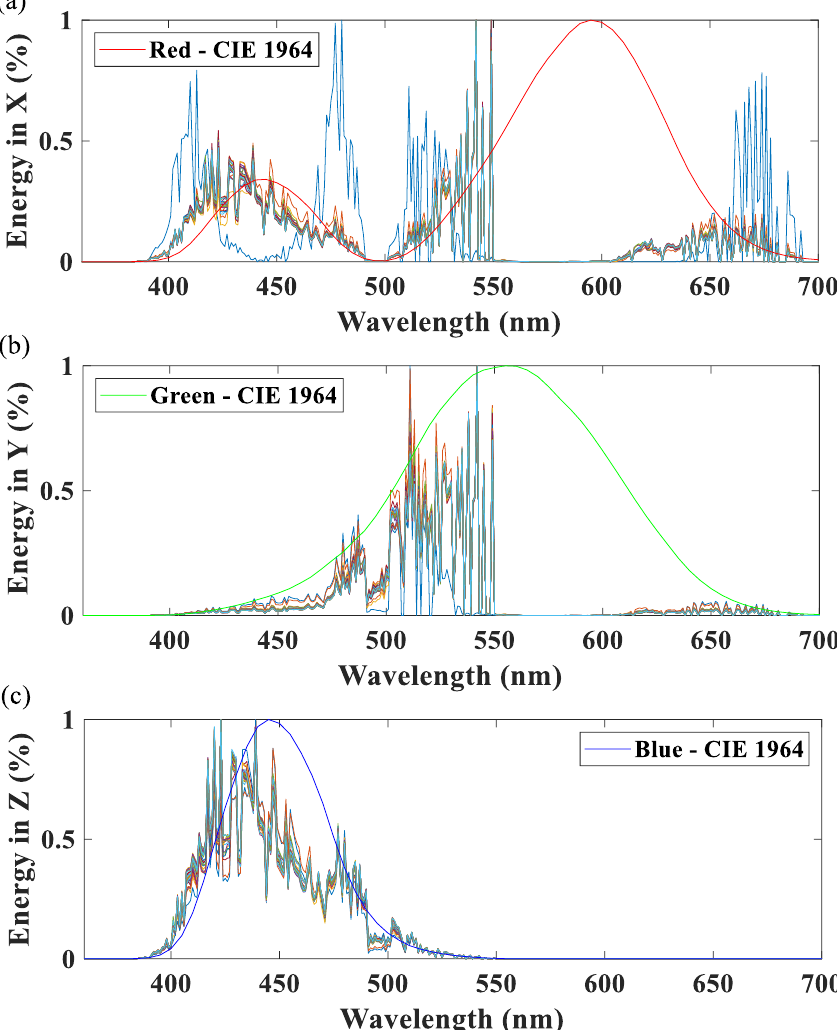
Figure 5. Camera and single-slit diffraction for the 27 case studies under analysis. Normalised PDF for CIE standard 1964 in X ( a ), Y ( b ), and Z ( c ).